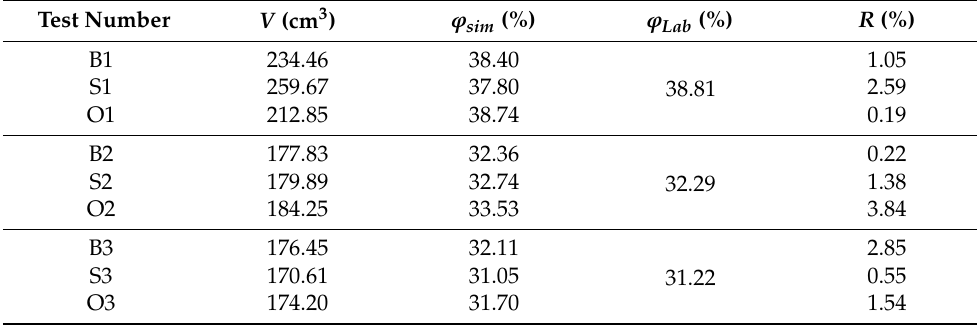
Figure 14. The pore network model of the packs. All models were cut in the middle to show their internal structure.